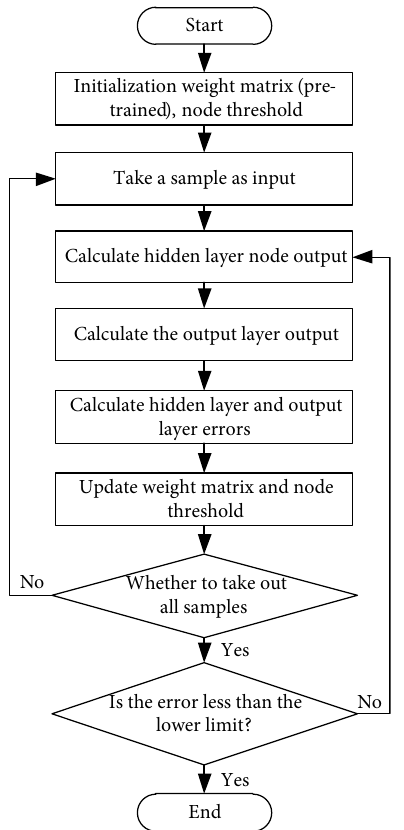
Figure 4: Calculation flow chart based on deep confidence